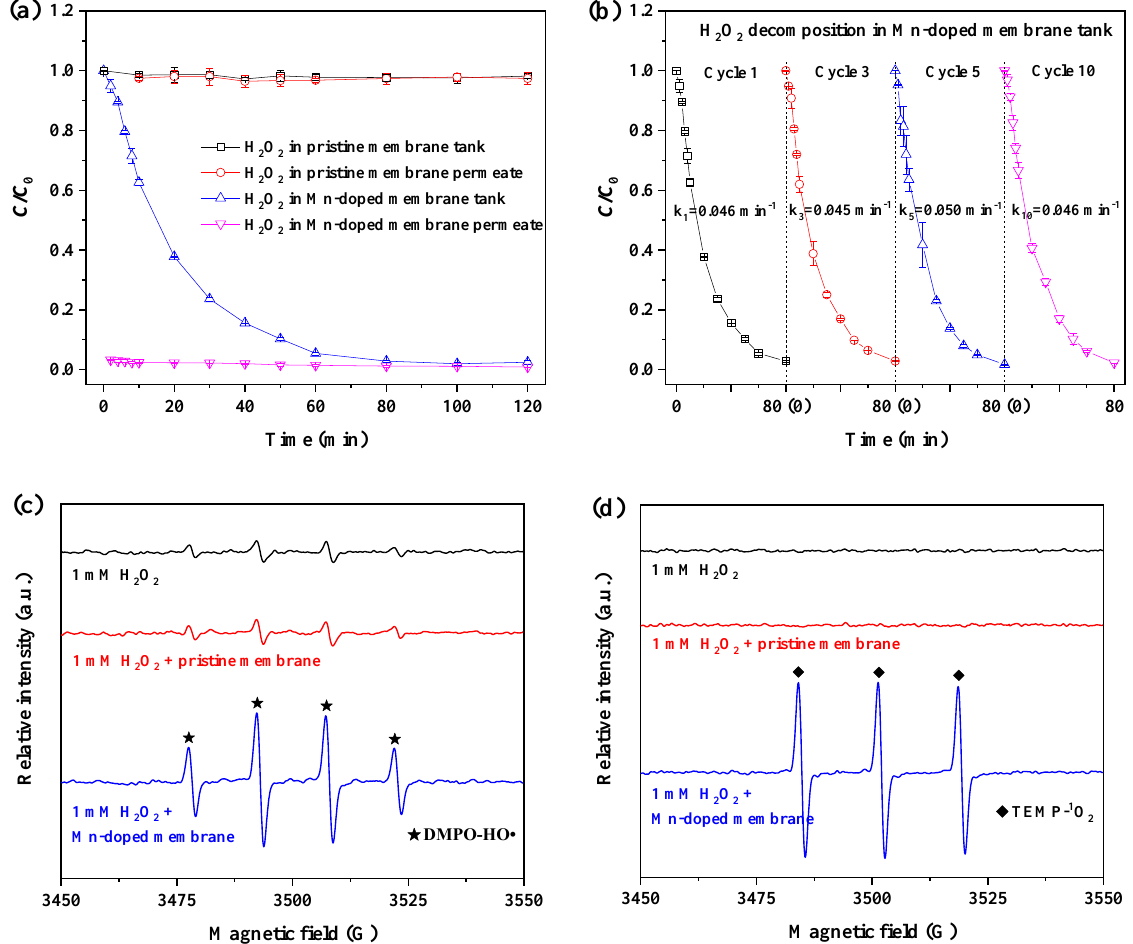
Figure 4. Catalytic activity of ( a ) fabricated ceramic membranes in H 2 O 2 decomposition and ( b ) an Mn-doped membrane cleaned with 1000 ppm NaClO solution (operating conditions: C 0 = [H 2 O 2 ] 0 = 1 mM; C is the concentration of H 2 O 2 in the membrane tank or permeation; membrane flux = 60 LMH); EPR spectra of ( c ) DMPO- HO• and ( d ) TEMP- 1 O 2 in 1 mM H 2 O 2 solution catalyzed by a pristine or Mn-doped membrane.